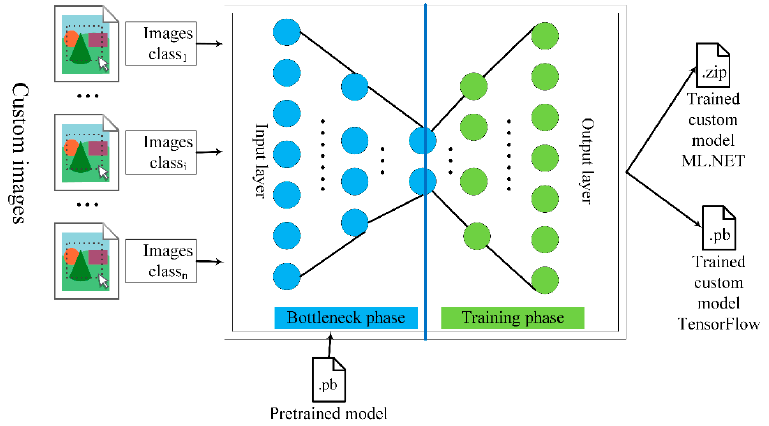
Figure 2. The training process using transfer learning.